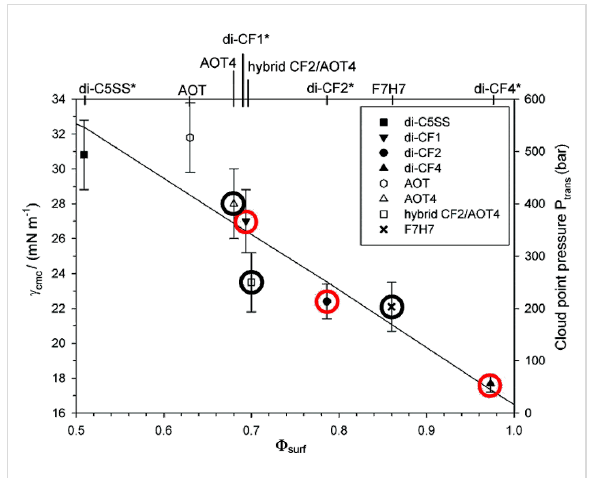
Figure 2: Correlation between relative surface coverage ( Φ surf ) – see Figure 1, limiting aqueous surface tension ( γ cmc ) and cloud point pres- sure ( P trans ). Circled points represent CO 2 -philic surfactants which are either fully fluorinated (red circles) or partially fluorinated (black circles), non-circled points represent non CO 2 -philic, hydrocarbon- based surfactants. There is a linear relationship between Φ surf , γ cmc and P trans , with higher surface coverage values corresponding to lower cloud point pressure and surface tension at cmc. Reprinted with permission from [59]. Copyright 2012 American Chemical